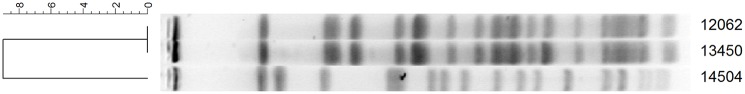
This is the Fig 1 PFGE analysis of NDM-1-producing K. pneumoniae.